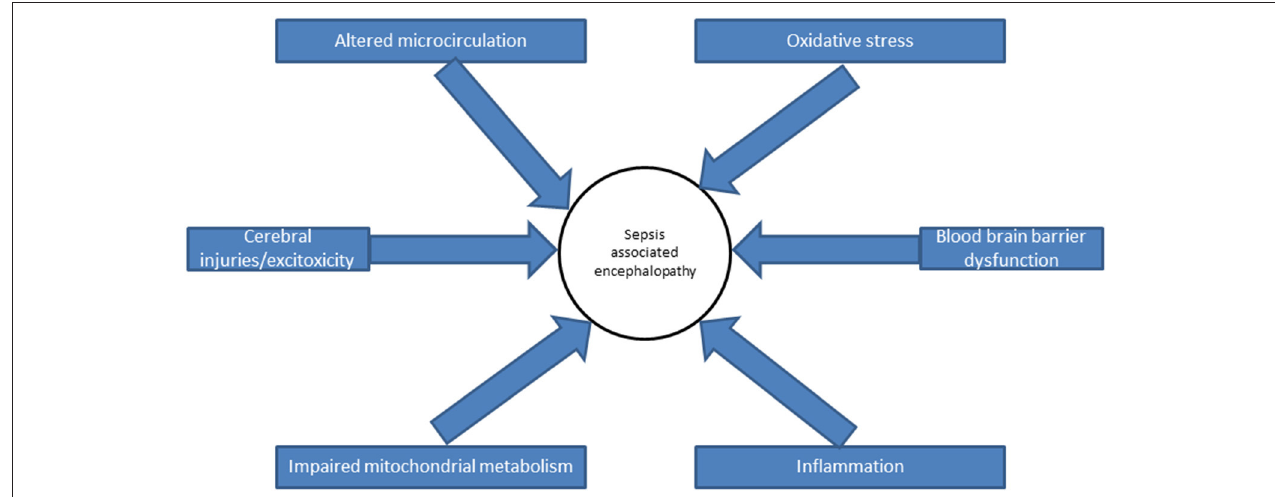
FIGURE 1 | Pathophysiology of sepsis associated